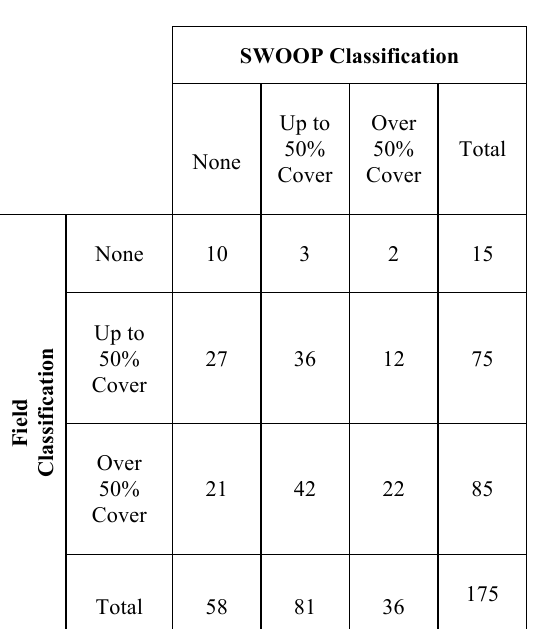
Table 3: A 3 x 3 matrix comparing the UAV classifications to the field classifications for percent cover of submerged aquatic vegetation ( p < 0.001).